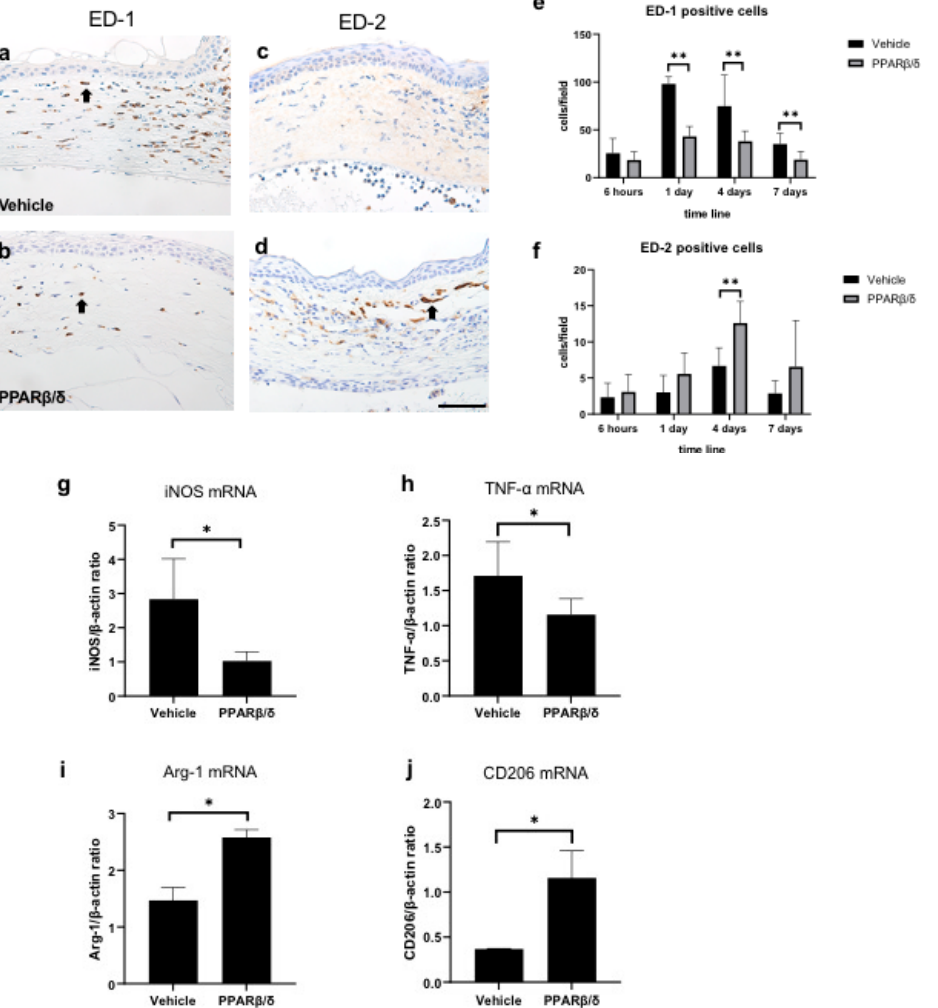
Figure 6. Immunostaining for ED-1 and ED-2. Pan-macrophages are stained with ED-1, and M2 macrophages are stained with ED-2. ED-1 immunostaining ( a : vehicle group, b : PPAR β / δ group) in the corneal limbus on day 1. ED-2 immunostaining ( c : vehicle group, d : PPAR β / δ group) in the corneal limbus on day 4. Black arrows: immunostained cells. Bar, 50 µ m. ED-1-positive cells were lower on days 1, 4, and 7. On the other hand, ED-2-positive cells were higher on day 4 in the PPAR β / δ group versus the vehicle group ( e , f ). The mRNA levels of the indicated M1 (iNOS and TNF- α ) ( g , h ) and M2 (Arg-1, and CD206) ( I , j ) at 6 h. The M1 markers were lower and the M2 markers were higher in the PPAR β / δ group as compared to the vehicle group. Data are presented as mean ± SD ( n = 8) ** p < 0.01 or * p < 0.05